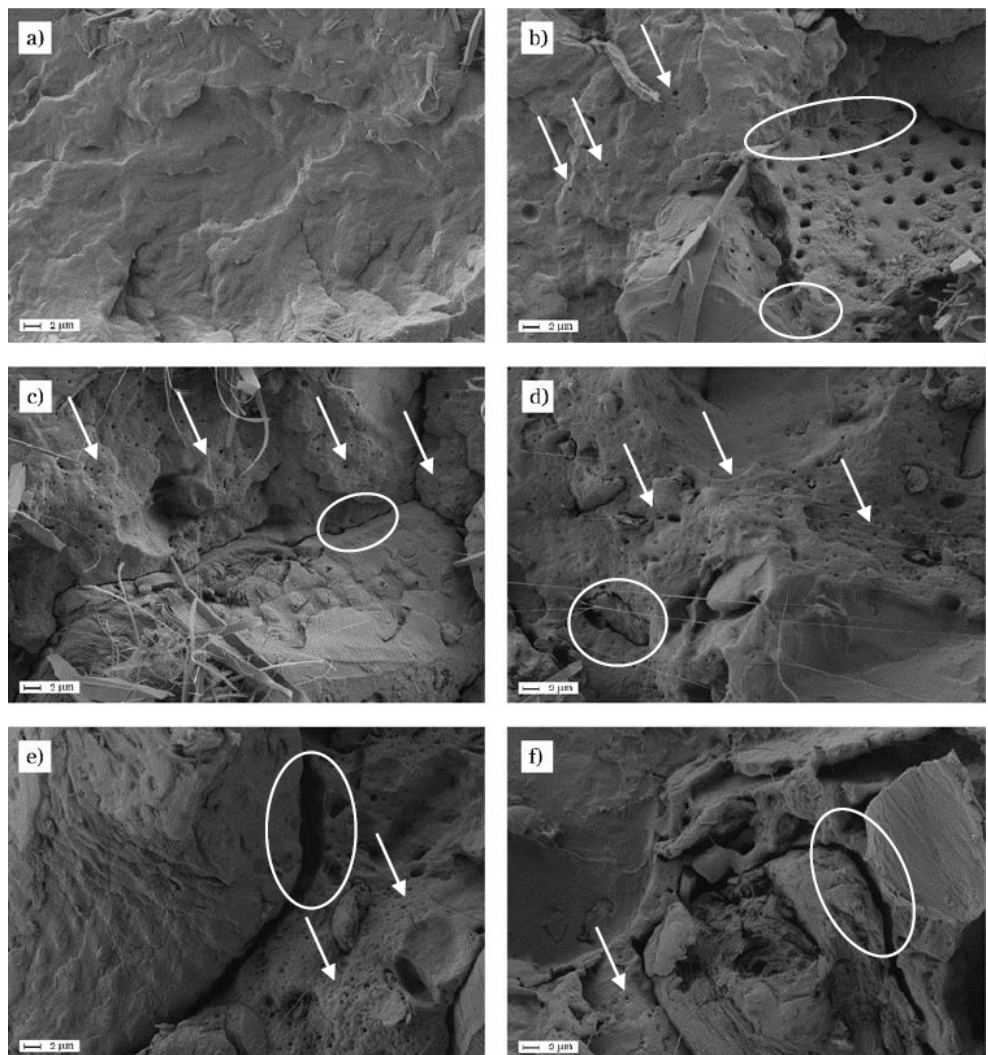
Figure 4. Field emission scanning electron microscopy (FESEM) images (2000×) of PBS/ASF/MLO composites with varying ASF content: ( a ) neat PBS; ( b ) 10 wt % ASF, 1.5 wt % MLO; ( c ) 20 wt % ASF, 3.0 wt %; ( d ) 30 wt % ASF, 4.5 wt %; ( e ) 40 wt % ASF, 6.0 wt %, and ( f ) 50 wt % ASF, 7.5 wt %.